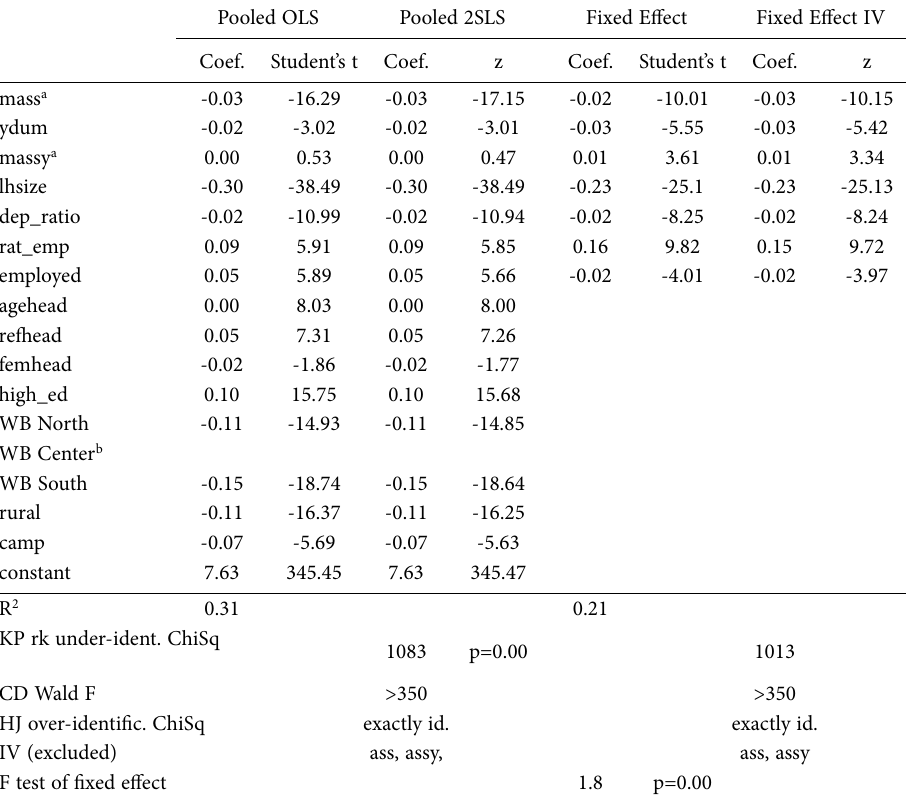
Table 10. Asset-based poverty index regression models, West